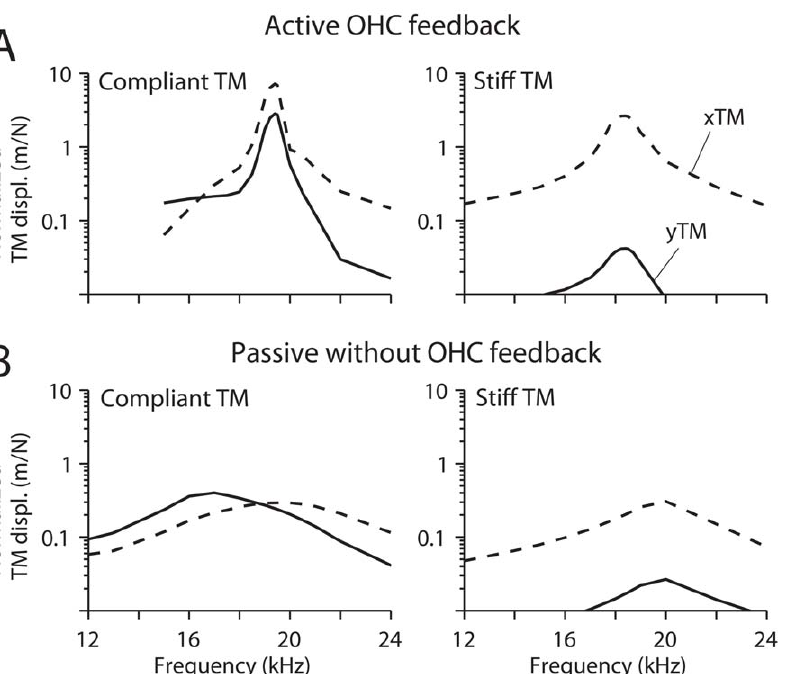
Figure 7. Effect of tectorial membrane stiffness for active and passive responses at the base. ( A ). Active case with OHC feedback. The frequency response of the cochlear partition for a sinusoidal force applied to the basilar membrane for compliant (left) and stiff (right) tectorial membrane. The radial ( x , solid lines) and transverse ( y , broken lines) displacement of the tectorial membrane are plotted against stimulation frequency. ( B ) Passive case without OHC feedback. Stimulation conditions and line forms are the same as in (A).